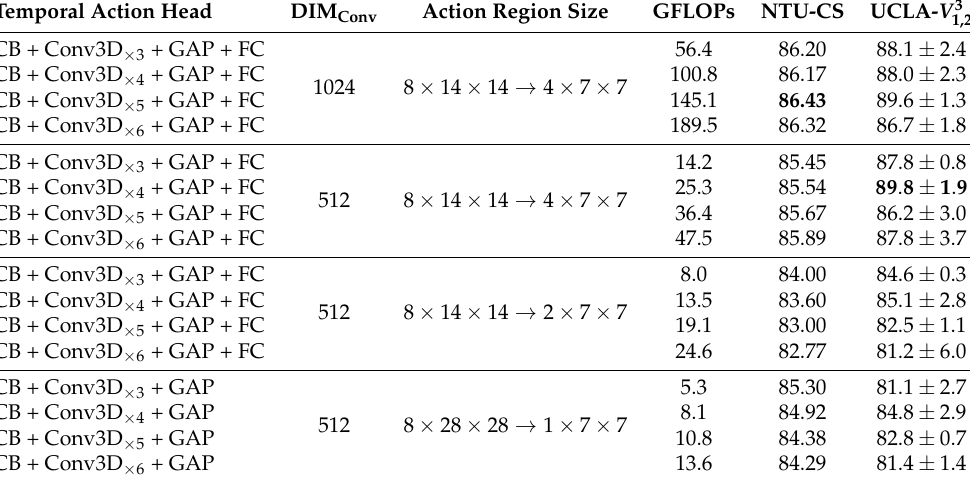
Table 7. Experimental results according to the network complexity. DIM Conv means the output channel dimension of Conv3D